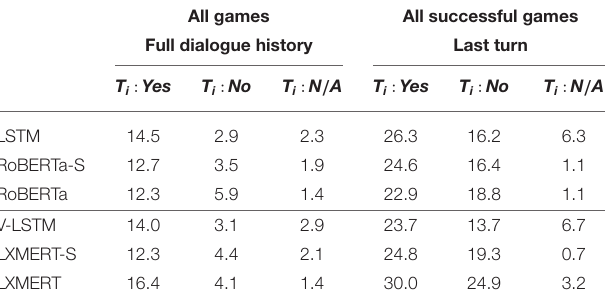
TABLE 4 | Change across consecutive turns in the probability assigned to the − P ( o ) T target after Yes- vs. No- vs. N/A-turns, i.e., P ( o ) T (full dialogue history in i + 1 i the full test set) and before/after the last turn (Last turn in games on which the model has succeeded). All